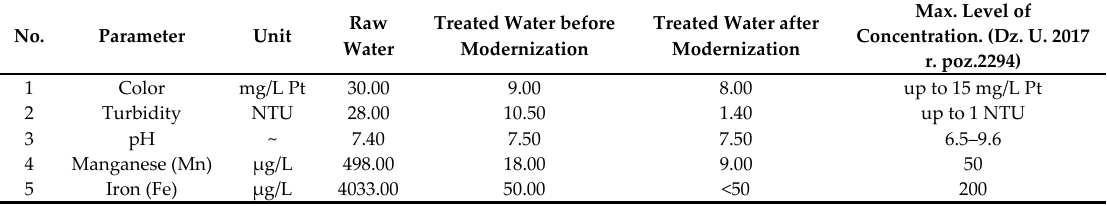
Table 1. Results of the water test at the water treatment plant in Pelele in the municipality of